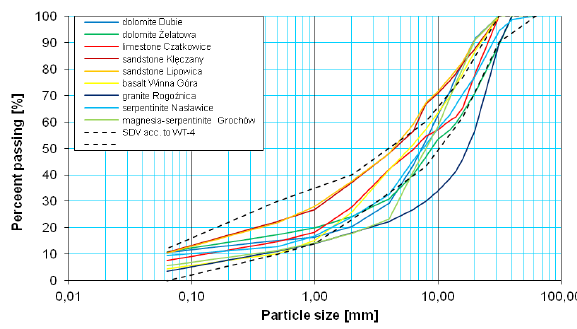
Figure 1: The curves of grain composition of the mixtures of 0/31.5 mm with the area of good granulation for subbase (SDV acc. to WT-4 [23]).